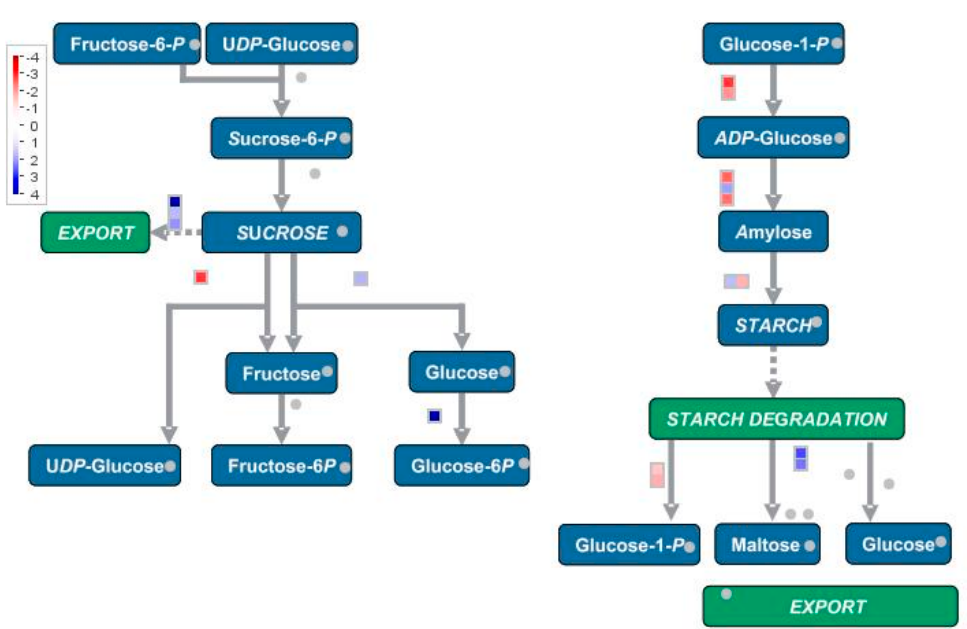
Figure 5. Pathway level display of genes involved in sucrose and starch metabolism, produced with MapMan [31]. Changes of transcripts levels in Myc and Non-Myc Oeceoclades maculata roots are indicated in the squares. Blue squares represent genes up-regulated, whereas red squares represent genes down-regulated in Myc roots, as compared with Non-Myc roots. Grey dots represent genes that were not mapped in the current dataset. A reference scale is on the left.